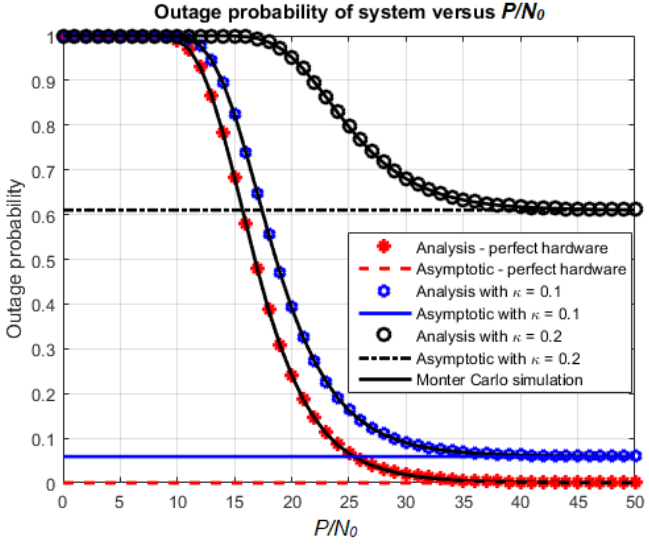
Figure 3. Outage probability versus P / N 0